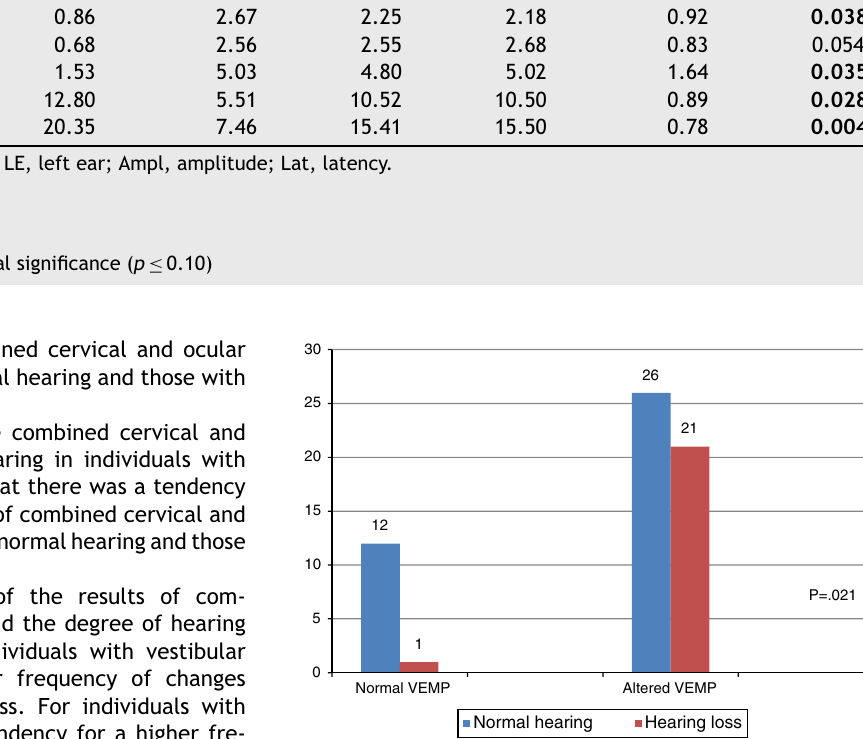
When comparing the results of cervical and ocular VEMP, no differences were observed for the frequency of normal and altered responses in the group with vestibular hypore- flexia and in the group with Ménière’s disease.